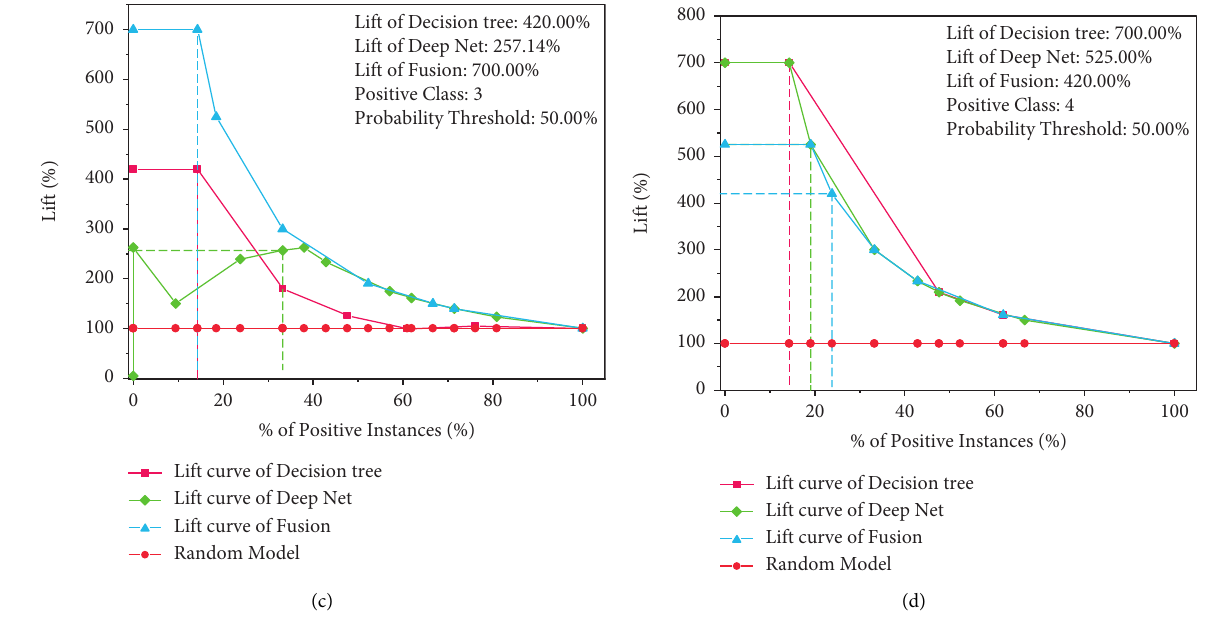
Figure 21: Lift curve of each classification test of the fusion model.